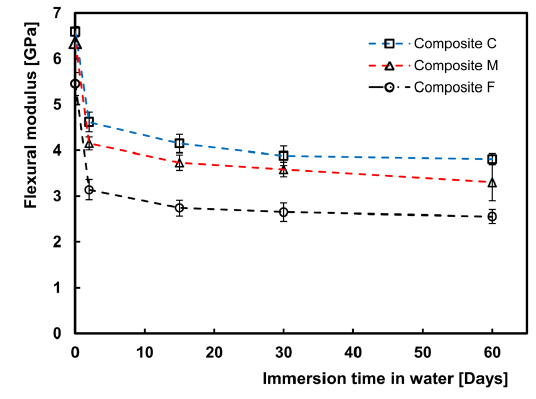
Figure 4. Curves of the flexural stress versus the displacement.